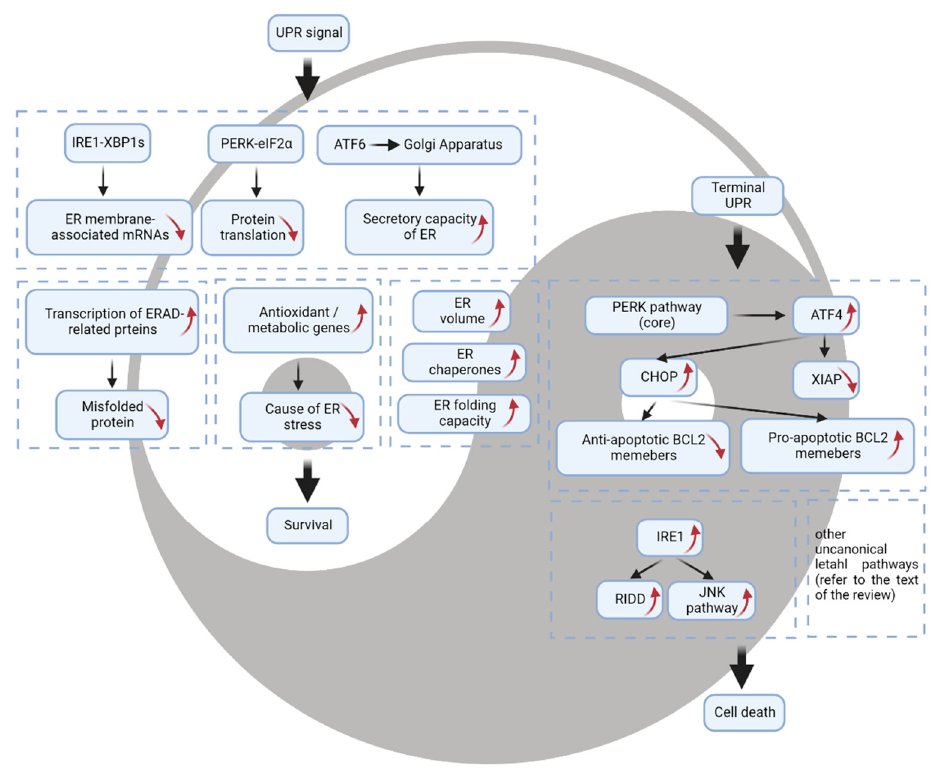
Figure 2. The “Yin and Yang” of the unfolded protein response. When cells experience loss of ER homeostasis, UPR will be activated, as a first attempt to attenuate protein load in the ER lumen and restore proteostasis. However, if the UPR fails to restore ER folding capacity, the UPR will enter the terminal phase to induce cell death. Up-arrow in red indicates up-regulation; Down-arrow in red indicates down-regulation.